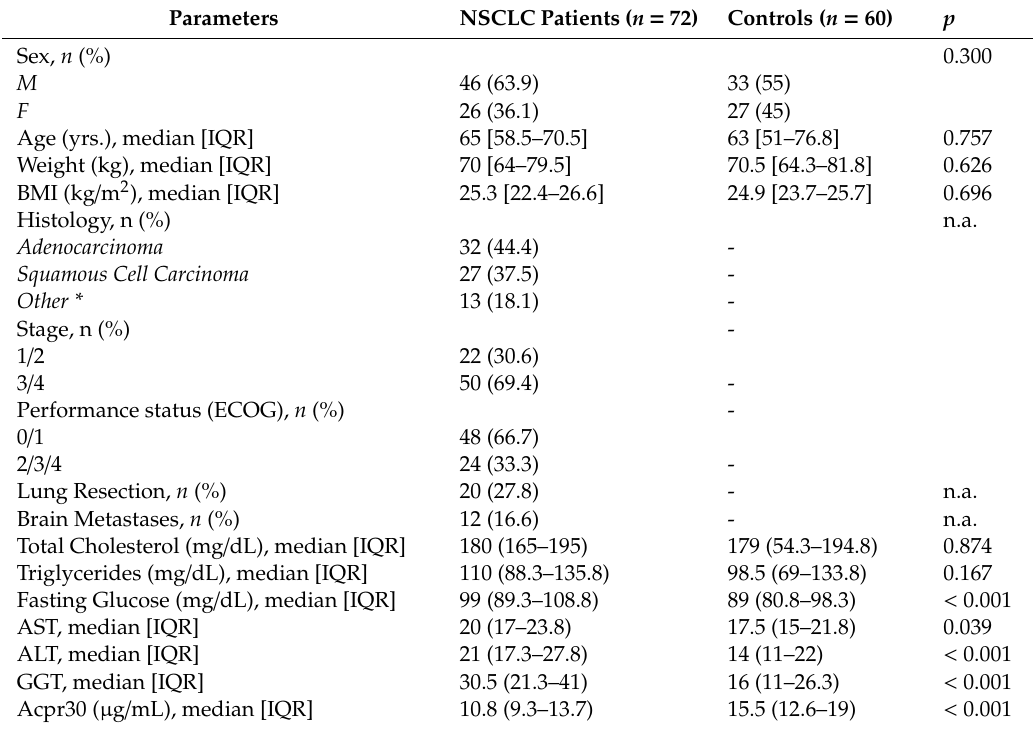
Table 1. Anthropometric, clinical, and biochemical features in controls and lung cancer patients.